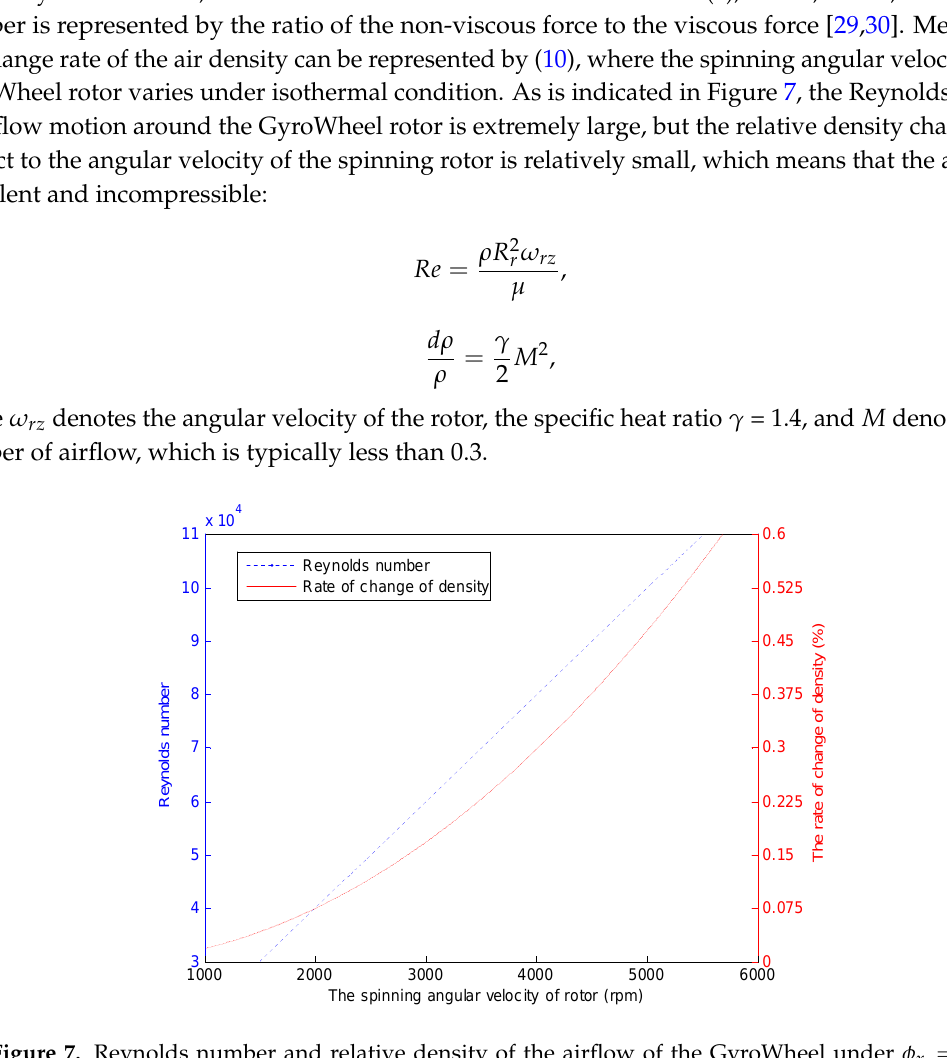
Figure 7. Reynolds number and relative density of the airflow of the GyroWheel under φ x = 0 ◦ , φ y = 0 ◦ and other conditions listed in Table